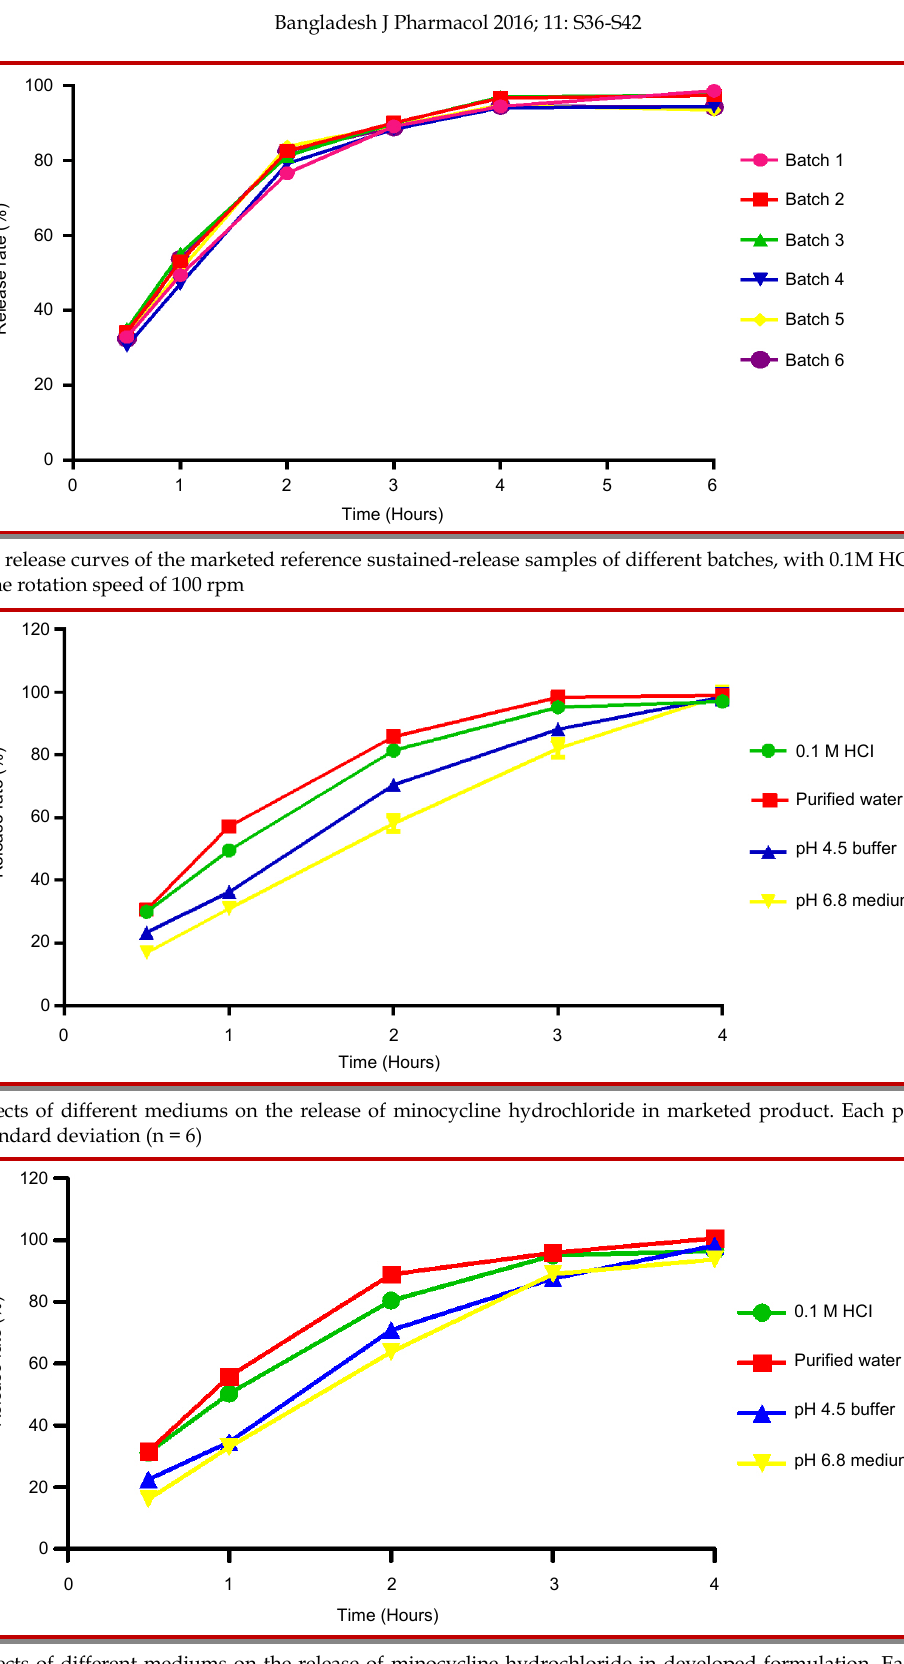
Figure 3: Effects of different mediums on the release of minocycline hydrochloride in developed formulation. Each point repre- sents average ± standard deviation (n =